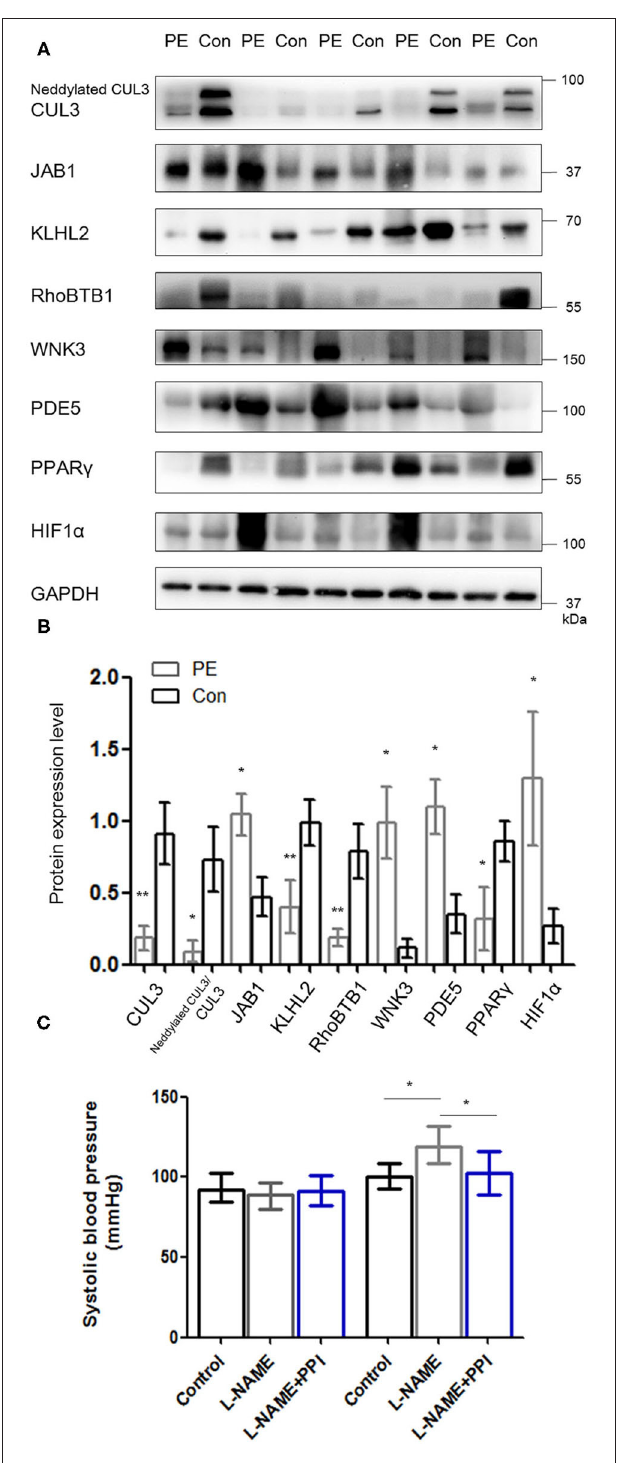
FIGURE 1 | Downregulation of CRL3 function with accumulation of WNK kinases and PDE5 was detected in the placentas of PE patients. (A , B) Western blotting was performed in the placentas of PE patients and healthy pregnancies, including (1) CUL3 and the ratio of neddylated CUL3 to deneddylated CUL3, (2) the member of the COP9 signalosome JAB1, (3) the adaptors of CRL3 including KLHL2 and RhoBTB1 and their specific substrates